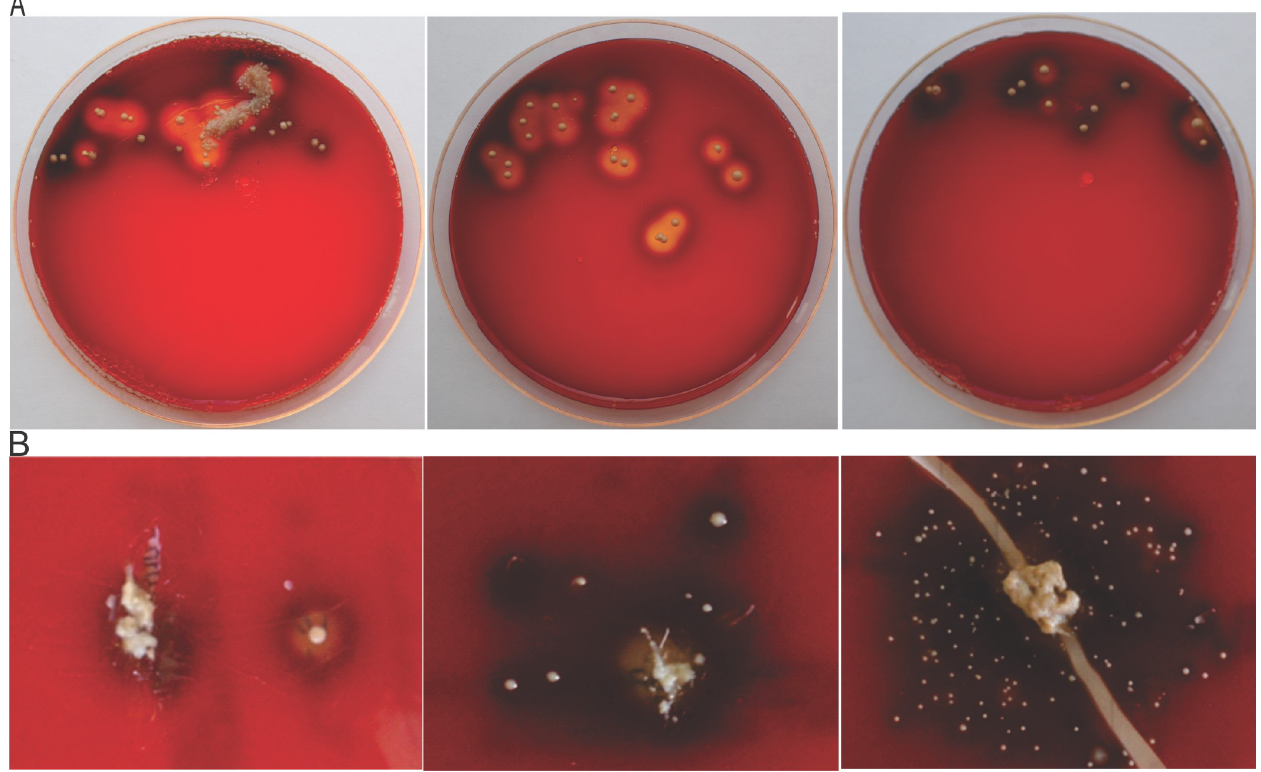
Fig 1. Hemolytic activity of P . acnes in infected intervertebral disc tissue. Fragments of disc tissue were streaked over the surface of the blood agar plates before pressing and embedding into the agar surface for incubation. Some bacterial colonies (subsequently identified as P . acnes ) show β -hemolysis (clearing of the blood agar), others show no hemolysis and/or production of porphyrins as a dark brown pigmentation with no clearing of the blood agar. (A) Images of hemolysis from intervertebral disc tissue obtained from Capoor et al . study [14]. (B) Images of hemolysis from herniated disc tissue received from Albert et al . study